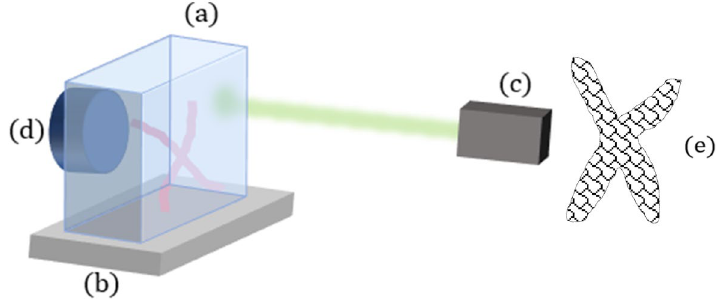
Figure 2. Experimental setup. A wax gel phantom ( a ) is put onto a moving stage ( b ). Photoacoustic excitation laser ( c ) excites the particles with a beam significantly larger than the width of each particle bubble. The signal is recorded using a piezo-electric transducer ( d ). A demonstration of phantom sectioning into bubble divisions (larger particles) is seen in ( e